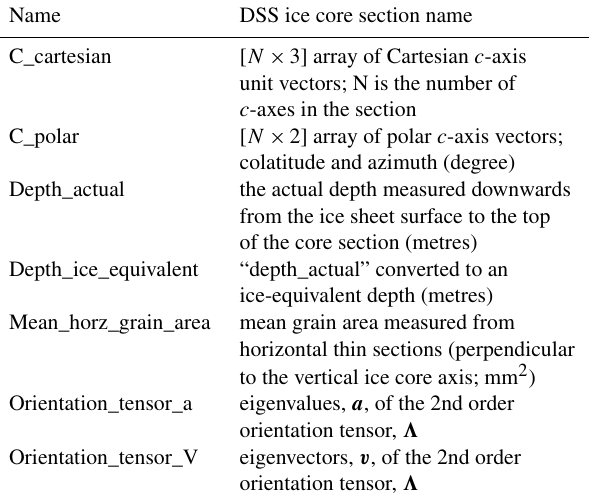
Table 3. Format of the MATLAB ™ R2015b structure array, DSS_fabric_data.mat , which contains DSS ice core crystal- lographic c -axis orientation and mean grain area